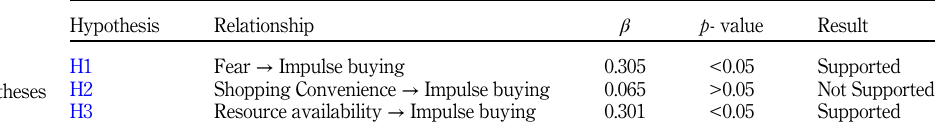
Table 3. Results of hypotheses